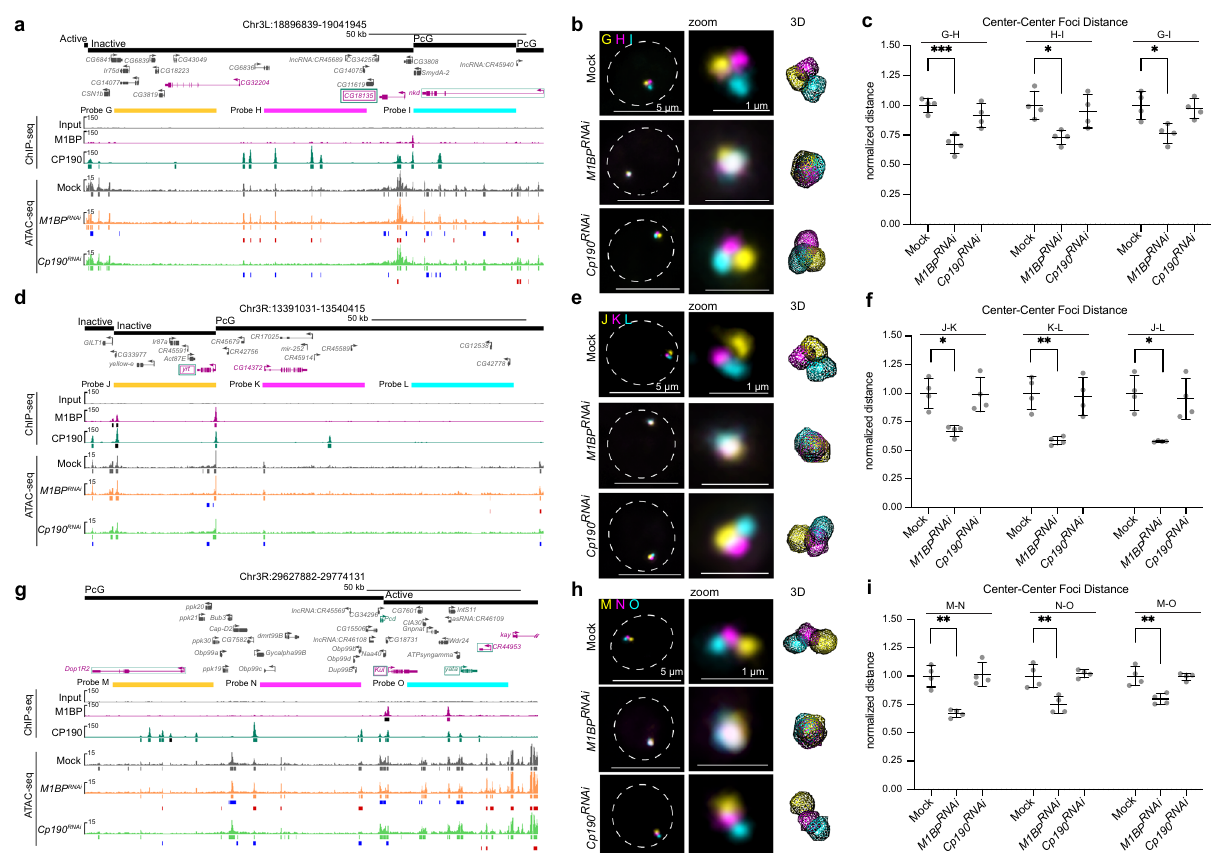
Fig. 8 Knockdown of M1BP increases local inter-TAD and intra-TAD genome compaction. a , d , g Regions detected by 32 kb probes spaced 15 kb apart ( a probes G, H, I; d probes J, K, L; g probes M, N, O). TADs with state classi fi cation, longest gene isoform, ChIP-seq signals, and called peaks (black signi fi cantly decreased in knockdown of opposite factor) are shown. ATAC-seq signals and called peaks, decreased peaks relative to mock (blue), and increased peaks (red) are shown. Upregulated genes in either M1BP or Cp190 knockdown are shown in purple or green, respectively. Downregulated genes in either M1BP or Cp190 knockdowns text outlined with a box are shown in purple or green, respectively. Note that nkd , Dop1R2 , and CR44953 are upregulated in both knockdowns, and CG18135 , yrt and Kul are downregulated in both knockdowns. b , e , h Left: representative nuclei labeled with probes in a , d , and g , respectively. Max projection of approximately 5 Z slices. Dashed line represents nuclear edge. Center: zoom of FISH signals. Right: TANGO 3D mesh rendering. c , f , i Dot plots showing average pairwise center-to-center distances between probes in a , d , and g , respectively. Data represented as mean of all replicates (mid-line) ± SD (error bars). Each dot represents the average of one replicate. Single-cell distances were normalized to nuclear radius before population averages were calculated. All averages were normalized to average of mock controls. Only cells in G1 were measured for these analyses. Data are from four biological replicates. See Supplementary Tables 10 – 12 for “ n ” of cells examined per replicate. Unpaired t -test (two-tailed) of means before normalization to controls (* P < 0.05, ** P < 0.01, *** P < 0.001). Exact P values can be found in Supplementary Table